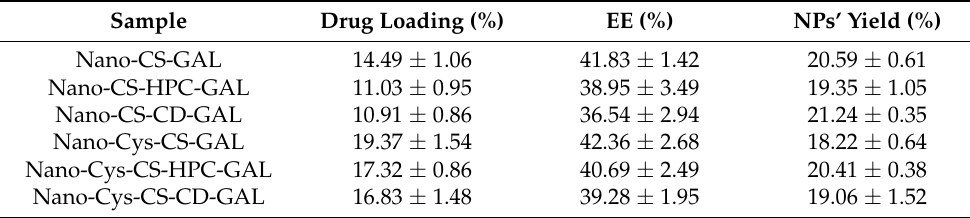
Table 1. Summary of drug loading, EE and NP yield